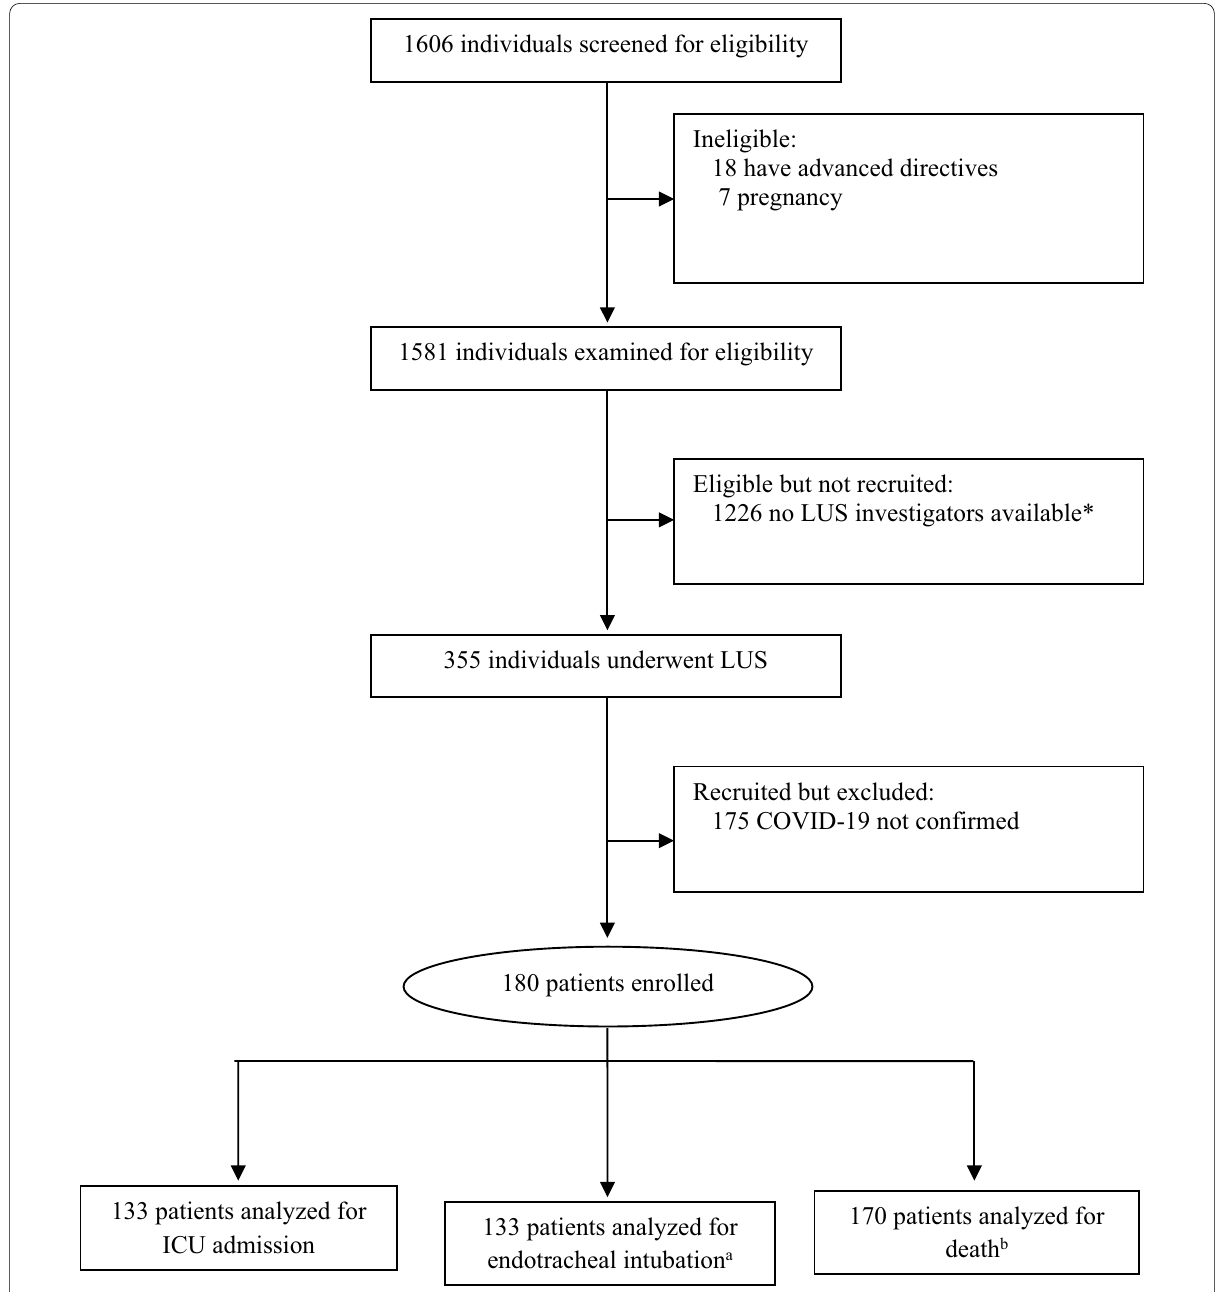
Fig. 1 Diagram of patient flow through the